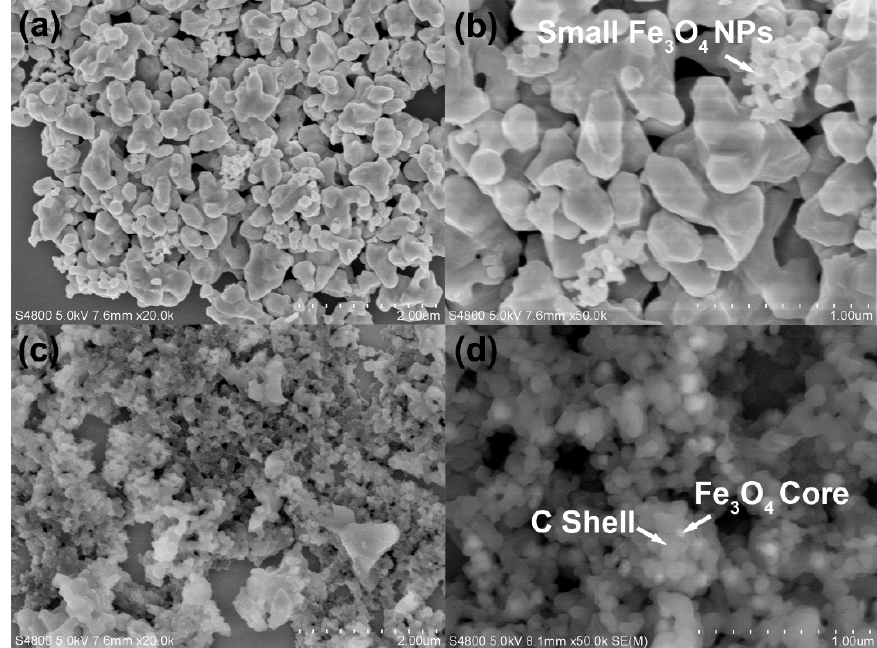
/ C composite nanoparticles ( c , d